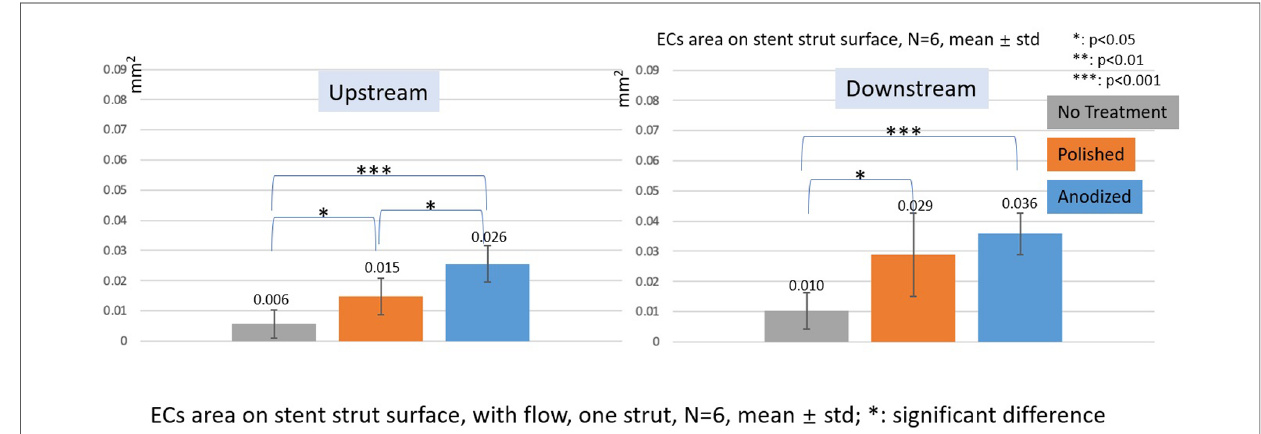
FIGURE 11 ECs area on stent strut surfaces, with fl ow 24-h, one strut, N =6, mean±std; T -test was performed to compare the signi fi cant difference (* p <0.05; ** p <0.01; *** p